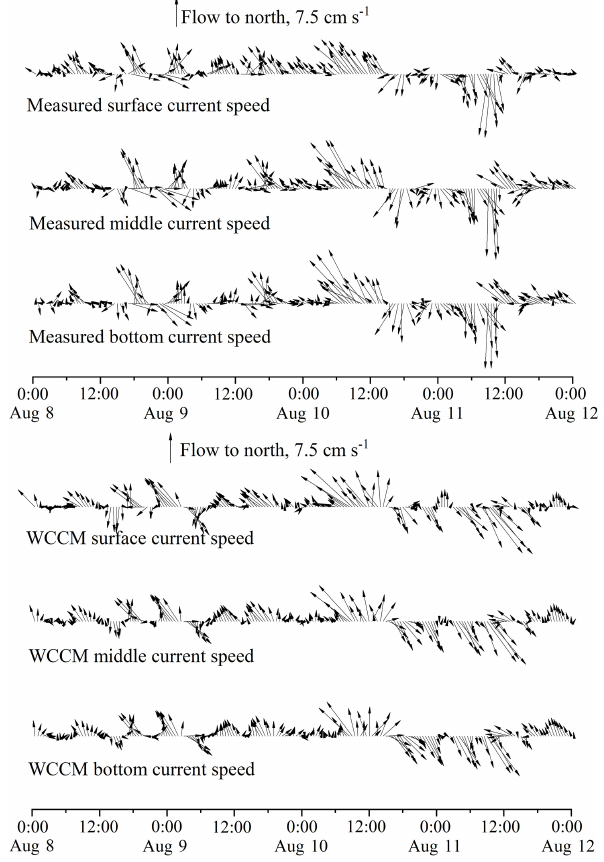
Figure 7. Comparison between the measured and WCCM- simulated current speeds in the lake surface, middle, and bottom water layers at the LHWS during the 2015 summer